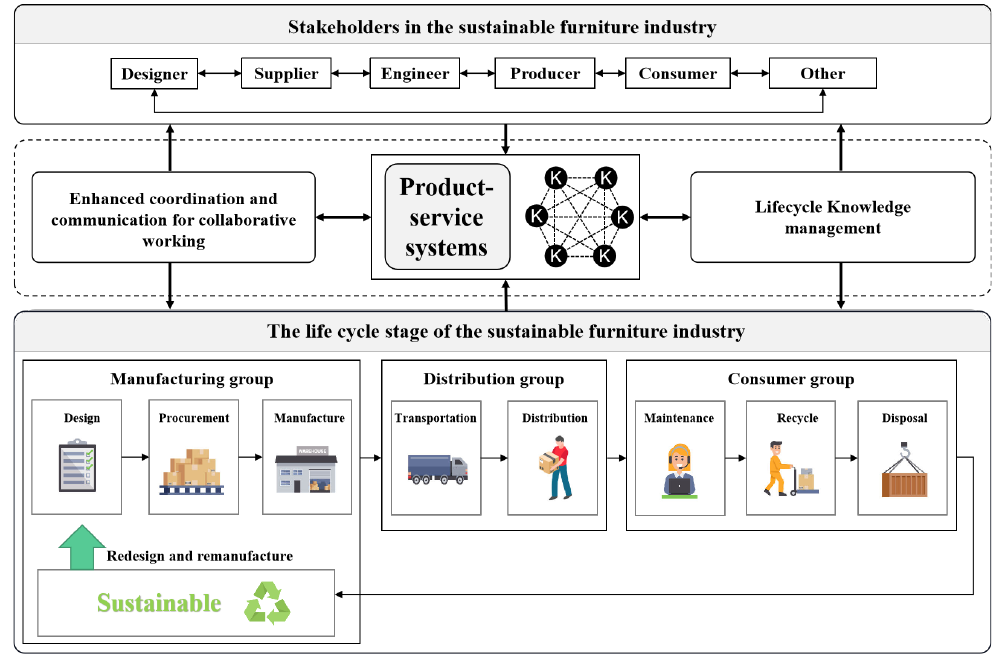
Figure 8. The lifecycle of sustainable furniture enhanced by PSSs IM (generated by authors).